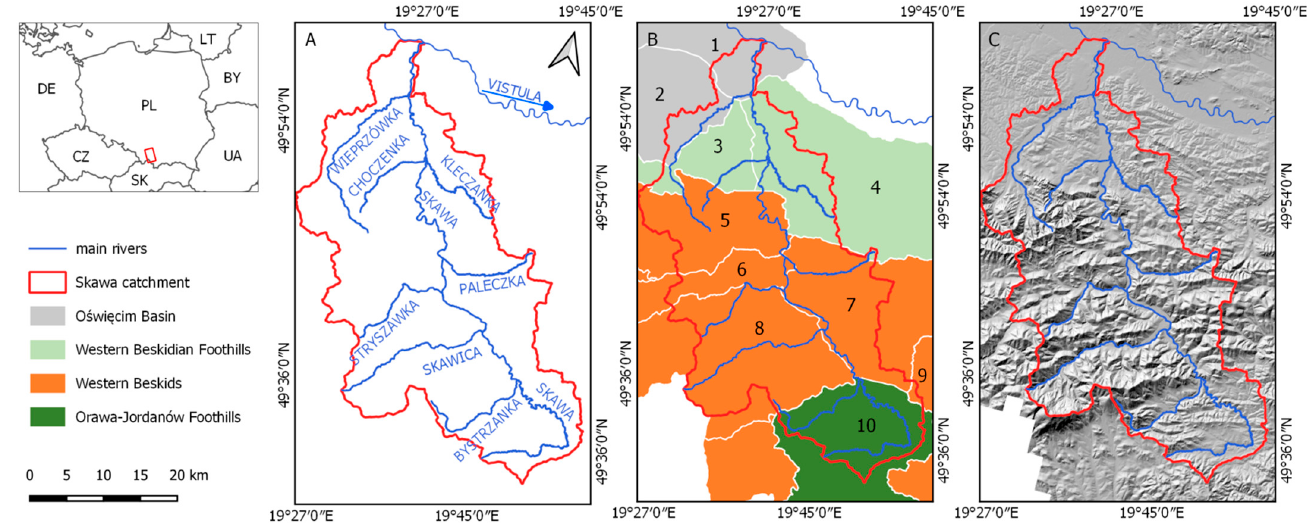
Figure 1. Research area. ( A )—the main rivers of the catchment; ( B )—physico-geographical regions: macroregion O ś wi ę cim Basin is divided into mesoregions: 1—Upper Vistula River Valley, 2—Wilamowice Submontane Region; macroregion Western Beskidian Foothills is divided into mesroegions: 3—Silesia Foothills, 4—Wieliczka Foothills; macroregion Western Beskids is divided